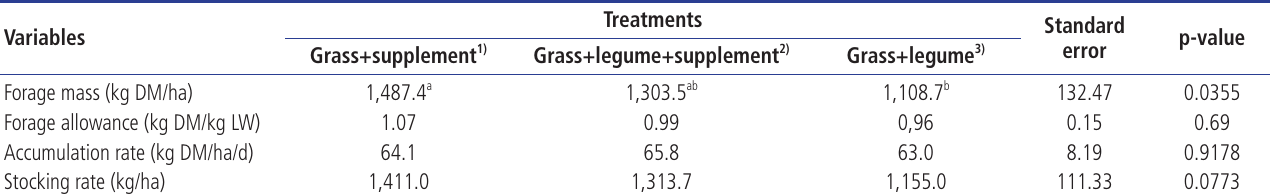
Table 2. Forage mass, forage allowance, accumulation rate and stocking rate in oat and ryegrass pastures mixed or not with vetch and with or without energy supplementation